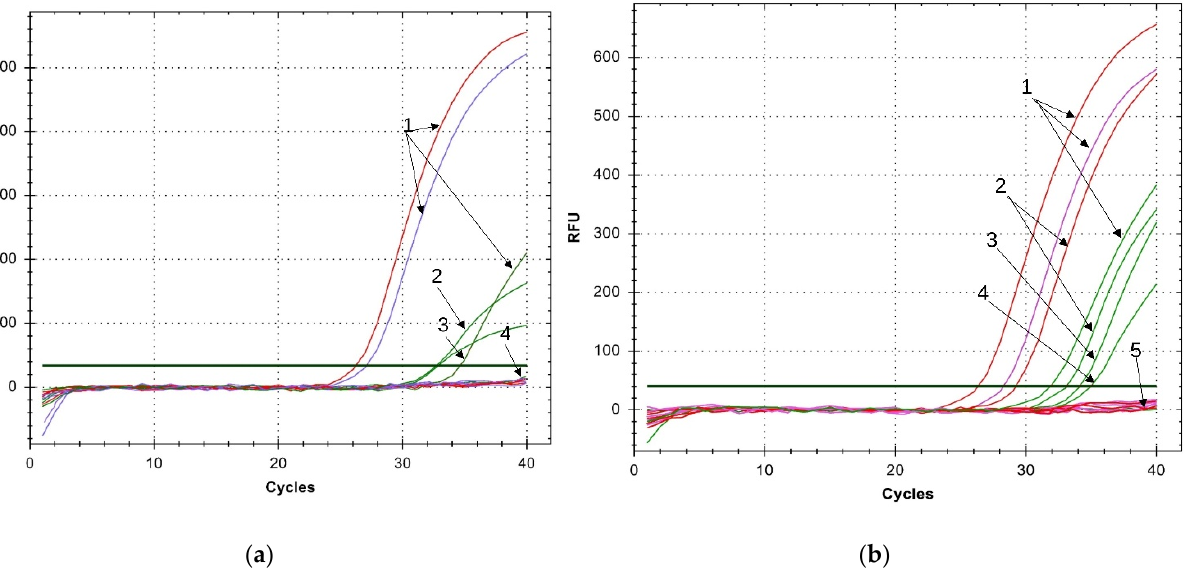
Figure 2. Amplification plots: ( a ) red line—helicase, blue line—nucleocapsid, green line— ABL1 , 1—SARS-CoV-2 positive sample; 2—SARS-CoV-2 negative sample; 3—frozen archival (2010) sample, 4—PBS; ( b ) red line—helicase; purple line—spike (Omicron); green line— ABL1 , 1—SARS-CoV-2 (Omicron) positive sample, 2—SARS-CoV-2 (non-Omicron) positive sample, 3—SARS-CoV-2 negative sample, 4—frozen archival (2010) sample, 5—PBS. Table 2. Threshold cycles (Tc) and interpretation of results for commercial (Syntol) kit and proposed set of primers.